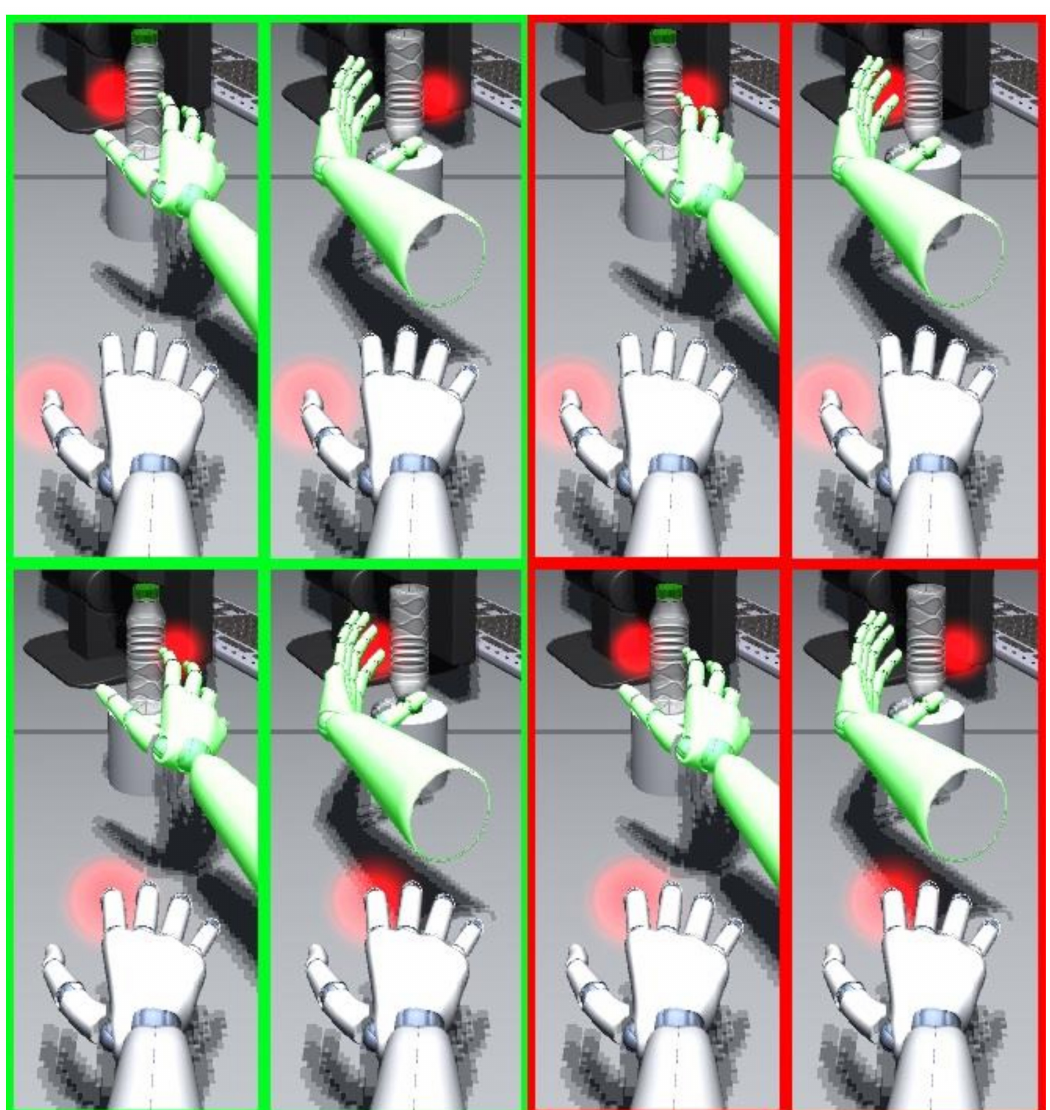
Figure 3. Stimulation conditions with respect to bottle orientation, visual distractor (red blob at the bottle), and vibrotactile stimulation (red blob at thumb or index finger). Green frames indicate stimulation conditions that are congruent with respect to the future finger position, red frames indicate incongruent conditions. Future hand positions are indicated by a green hand. Please note that the red blobs at the fingers were only added to visualize the vibrotactile stimulation and were not visualized in the